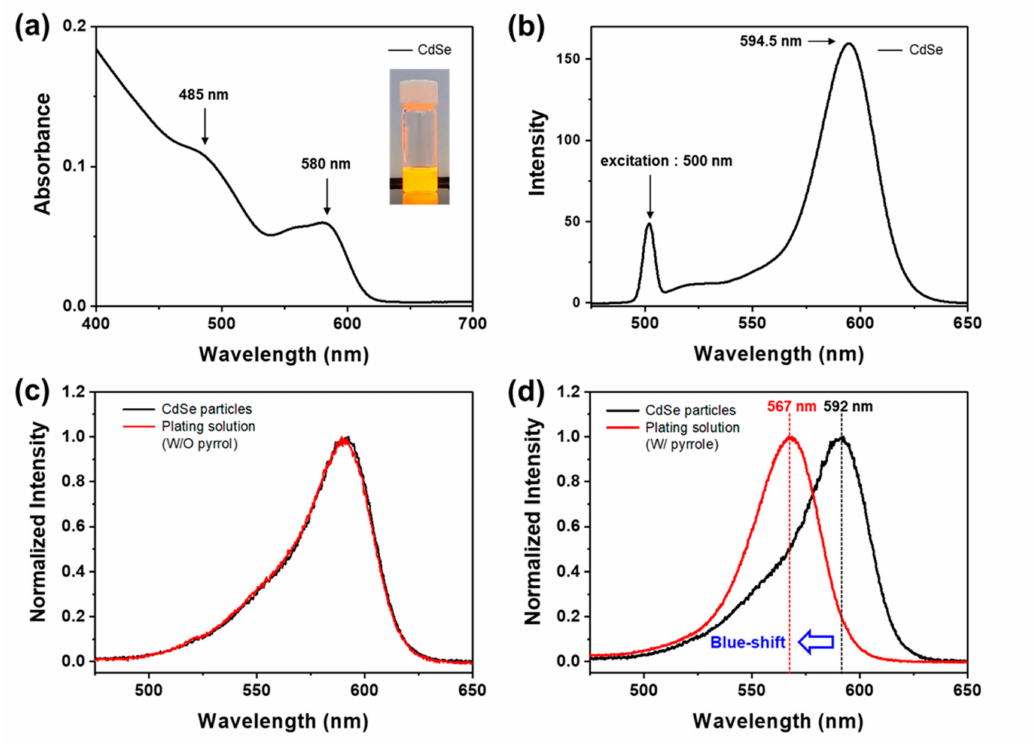
Figure 4. ( a ) UV–vis absorption spectrum of CdSe nanoparticles. ( b ) Photoluminescence (PL) spectrum of CdSe nanoparticles. The excitation wavelength of PL is 500 nm. PL spectra with ( d ) and without ( c ) pyrrole monomer in CdSe and plating solution